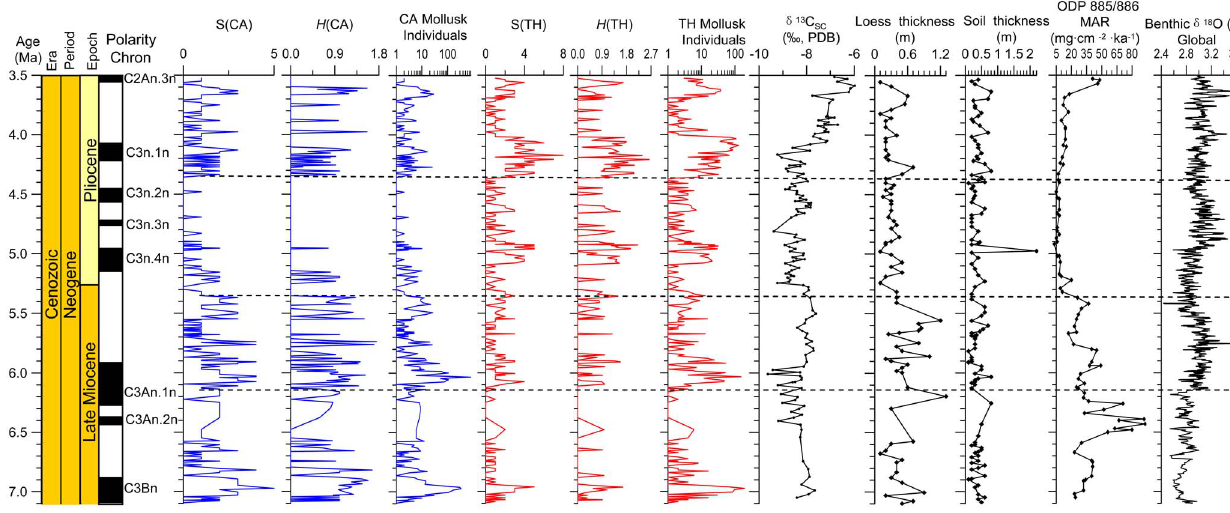
Figure 4. Variations in the terrestrial mollusks of the Dongwan sequence in the western CLP from 7.1 to 3.5 Ma, and comparison with other climate proxies. The proxies are d 13 C of soil carbonate ( d 13 C SC ) in the Lingtai Red Clay sequence [6], loess and soil thickness in the Dongwan sequence (this study), global cooling trend deduced from the marine benthic foraminiferal d 18 O record [1], and continental aridity inferred from the mass accumulation rate (MAR) of eolian dust at ODP Site 885/886 in the western Pacific [69]. Geomagnetic polarity chronology and age of the Dongwan sequence is from Hao and Guo (2004) [41]. S(CA)–Total species of the cold-aridiphilous (CA) mollusk group. H (CA)–Diversity of the CA mollusk group. S(TH)–Total number of species of the thermo-humidiphilous (TH) mollusk group. H (TH)–Diversity of the TH mollusk